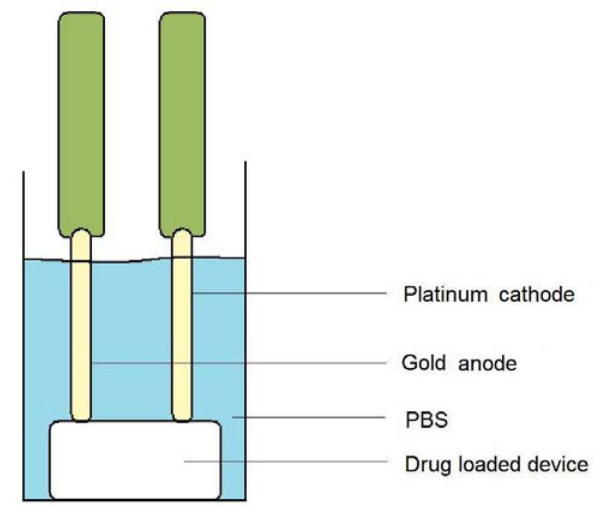
Figure 10. Pictorial showing the experimental setup for assessing the drug release behavior from the ECH